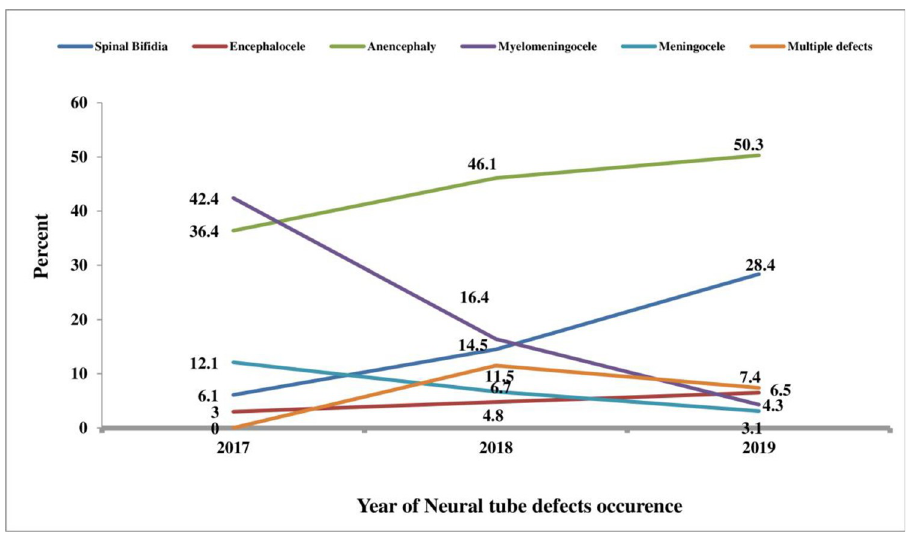
Fig 4. Yearly distribution of the occurrence of NTDs in Eastern Ethiopia, data from 2017–2019.